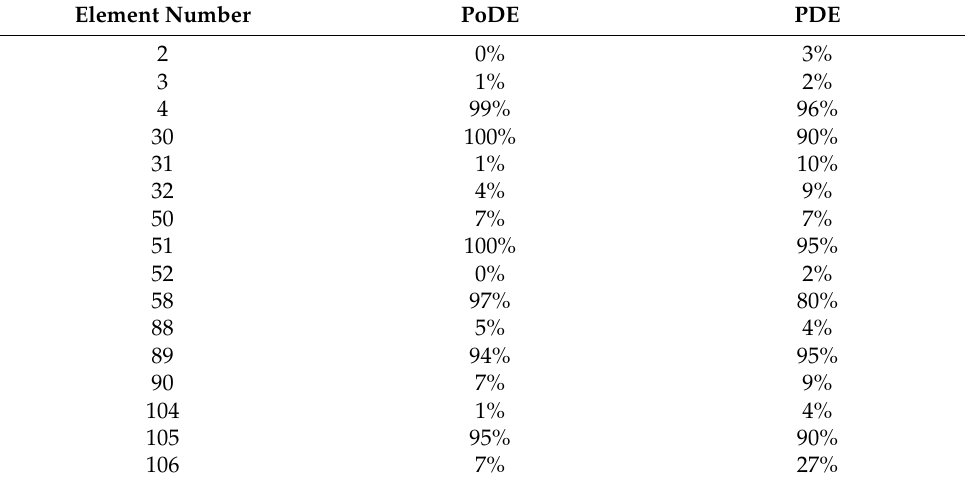
Table 9. PoDE for damage case 2 of the dome truss.